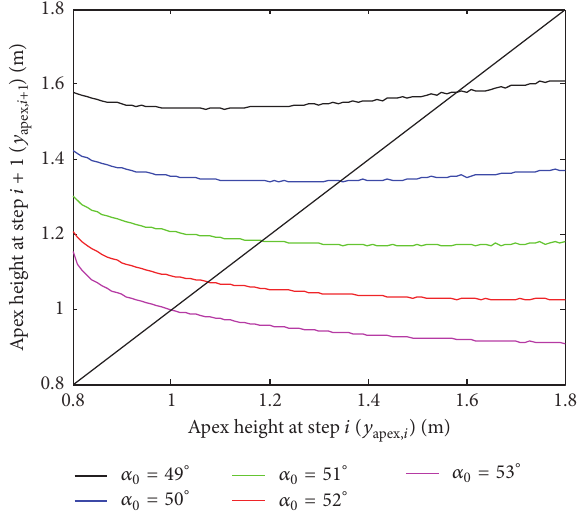
(𝑦 ) at different 𝛼 apex ,𝑖+1 apex ,𝑖